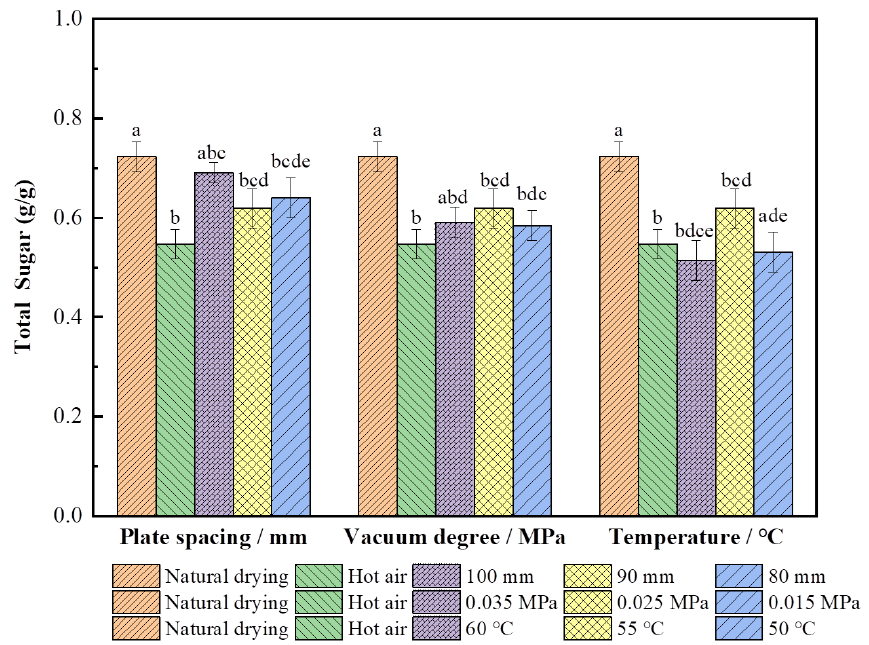
Figure 5. Total soluble sugar content of L. barbarum under different drying conditions. Note: Signifi- cant differences are represented by different letters ( p < 0.05).